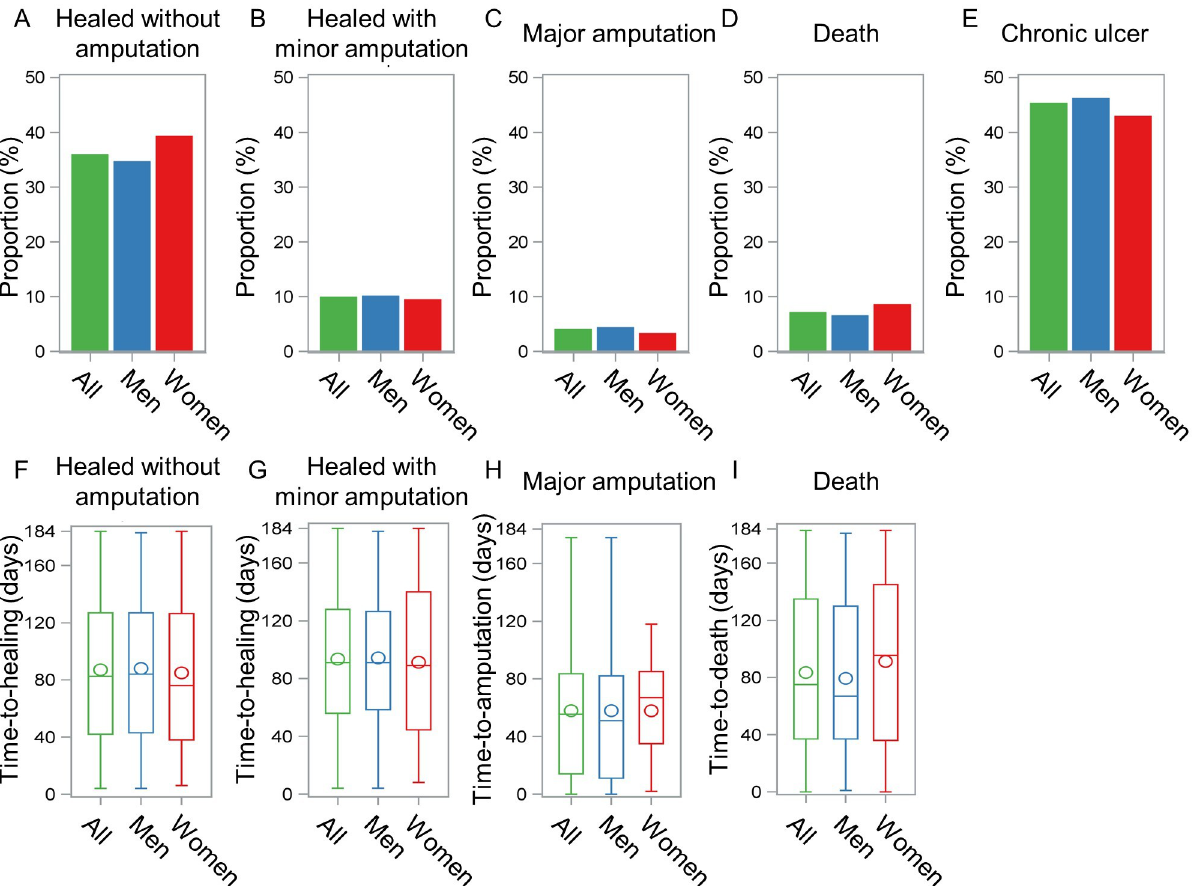
Fig 2. Outcome of the index DFU after 6 months for patients not lost to follow-up. A-E. Proportion of all patients (green, n = 1,707), male patients (blue, n = 1,238) or female patients (red, n = 469) who achieved the specified outcome during the follow-up period of maximum 6 months, being A. Healing without any amputation; B. Healing with minor amputation; C. Resolved by major amputation; D. Death or E. Chronic ulcer. Deaths were recorded throughout the follow-up period, bringing the total sum of the percentages above 100%, as some patients deceased after healing or major amputation. F-I. Boxplots showing the spread of the time (in days) to an event, being F. Healing without any amputation; G. Healing with minor amputation; H. Major amputation or I. Death. The median time-to-event is indicated by the horizontal line, the mean time-to-event by the circle.